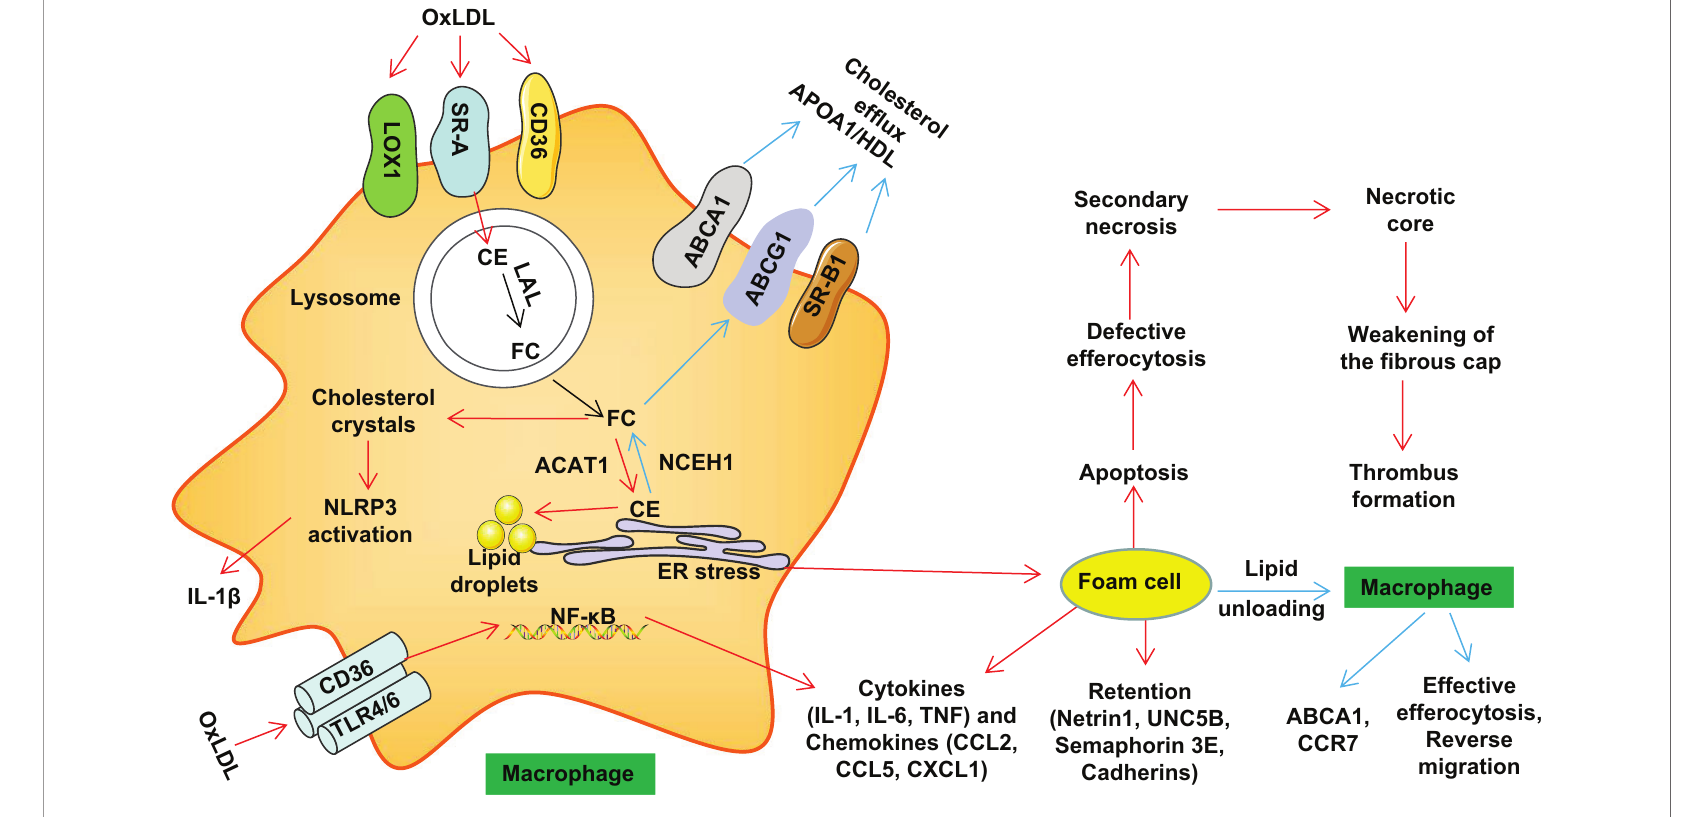
FIGURE 1 | Macrophage lipid metabolism disorder and thrombosis. Macrophages phagocytose accumulated LDL and modi fi ed LDL (such as oxLDL) through multiple cell membrane scavenger receptors such as LOX1, SR-A and CD36. In the lysosome, cholesterol ester (CE) in LDL particles is degraded to free cholesterol (FC) and free fatty acids by lysosomal acid lipase (LAL). In the endoplasmic reticulum (ER), FC is re- esteri fi ed by acetyl-coenzyme A: cholesterol acetyltransferase 1 (ACAT1), which contributes to CE accumulation and lipid droplet formation. CE is hydrolyzed by neutral cholesterol ester hydrolase 1 (NCEH1) to release FC, and is further transported to the outside of the cell through cholesterol ef fl ux transporters, ABCA1, ABCG1 and SR-B1, thereby maintaining cholesterol metabolism homeostasis. Under pathological conditions (such as AS), excessive accumulation of FC induces the formation of cholesterol crystals in the lysosome, which activates the NLRP3 in fl ammasome, induces ER stress, and ultimately leads to the formation of foam cells. OxLDL can also activate the NF- k B signaling pathway through the CD36 – TLR4/TLR6 trimer. Foam cells secrete macrophage chemotaxis retention factors (including netrin 1 and its receptor UNC5B, cadherins and semaphorin 3E), pro-in fl ammatory cytokines (such as IL-1, IL-6 and TNF) and chemokines (such as CCL2, CCL5 and CXCL1) amplify the in fl ammatory response. Over time, foam cells undergo apoptosis. When these apoptotic cells cannot be effectively cleared by macrophages in advanced disease (defective erythrocytosis), secondary necrosis will result. Further development will promote